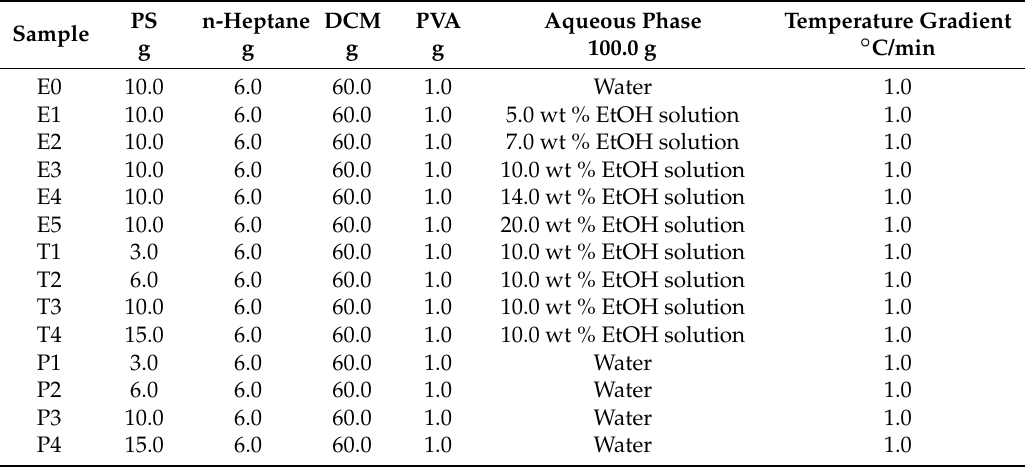
Table 1. Preparative conditions of polymeric microspheres. PS: polystyrene; DCM: dichloromethane; PVA: polyvinyl